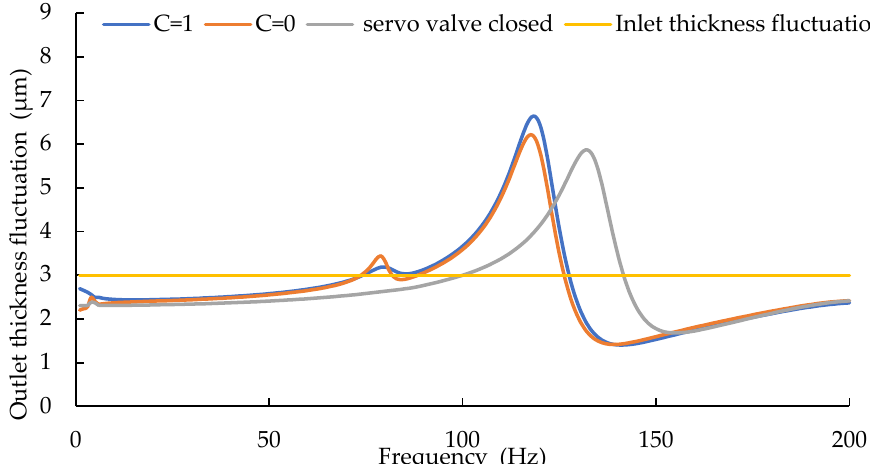
Figure 11. Thickness fluctuation diagram of strip steel at the inlet and outlet of rolling mill. It can be seen from Figure 9 that the thickness control effect of the rolling mill on the strip steel is different in different working conditions. The outlet thickness fluctuation of the strip steel is also different under the excitation of the inlet thickness at different fre ‐ quencies. In most frequency bands, the outlet thickness fluctuation is less than the inlet thickness fluctuation, which can lead to the ideal control effect. However, when the exci ‐ tation frequency of the strip steel meets the natural frequency of the mill, the rolling mill will have strong vibration, which will cause the outlet thickness fluctuation to be greater than the inlet thickness fluctuation, and worsen the quality of the strip steel.